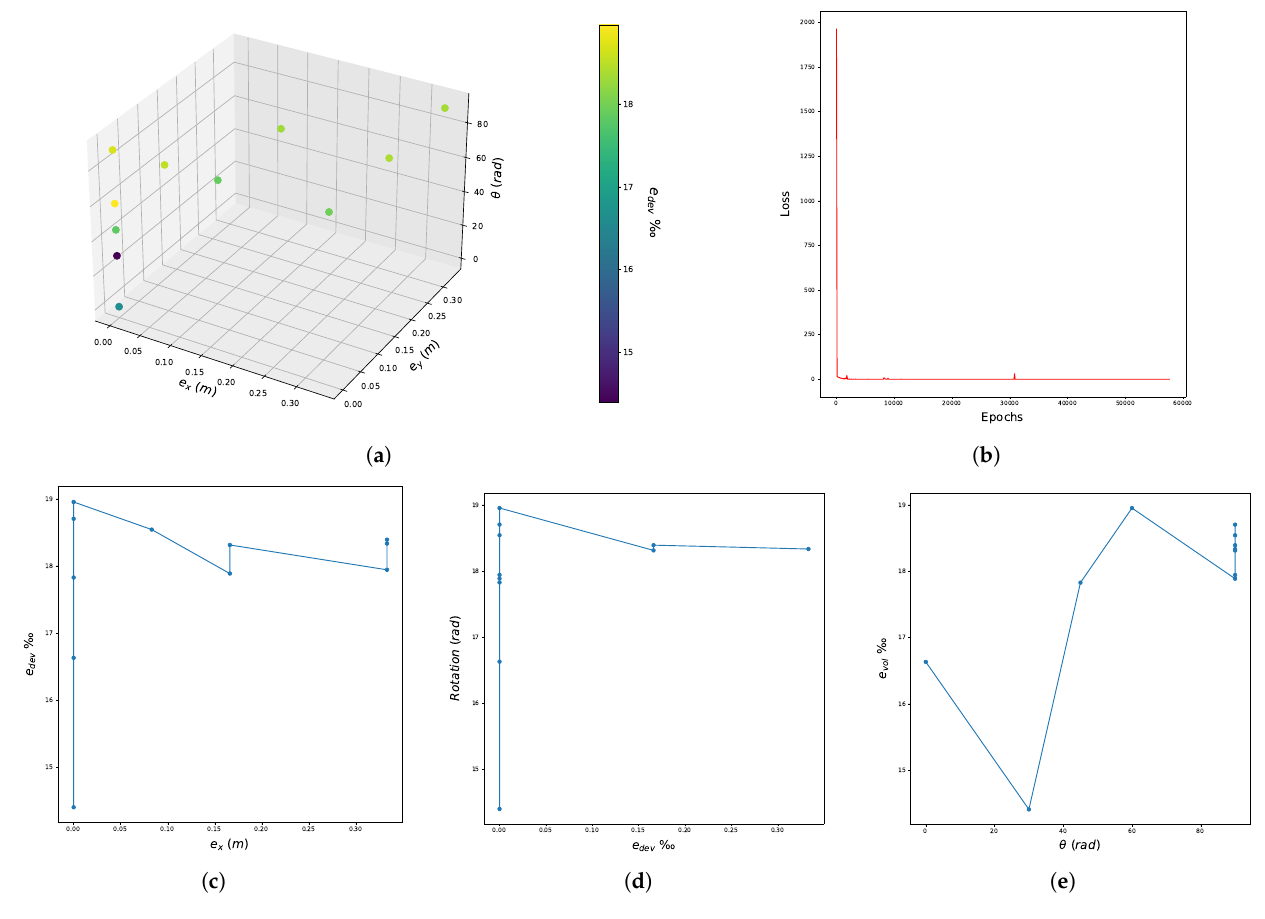
Figure 10. Graphical presentation of the Neural Network that corresponds to Monte Carlo analysis P - κ RF - c RF - k RF − 4 − 10 (NN10) for the estimation of the deviatoric component of the strain e dev . ( a ) 3D representation of the Neural Network. ( b ) Epochs-Loss diagram. ( c ) Neural Network representation in the projection of the input axis of e x . ( d ) Neural Network representation in the projection of the input axis of e y . ( e ) Neural Network representation in the projection of the input axis of θ .